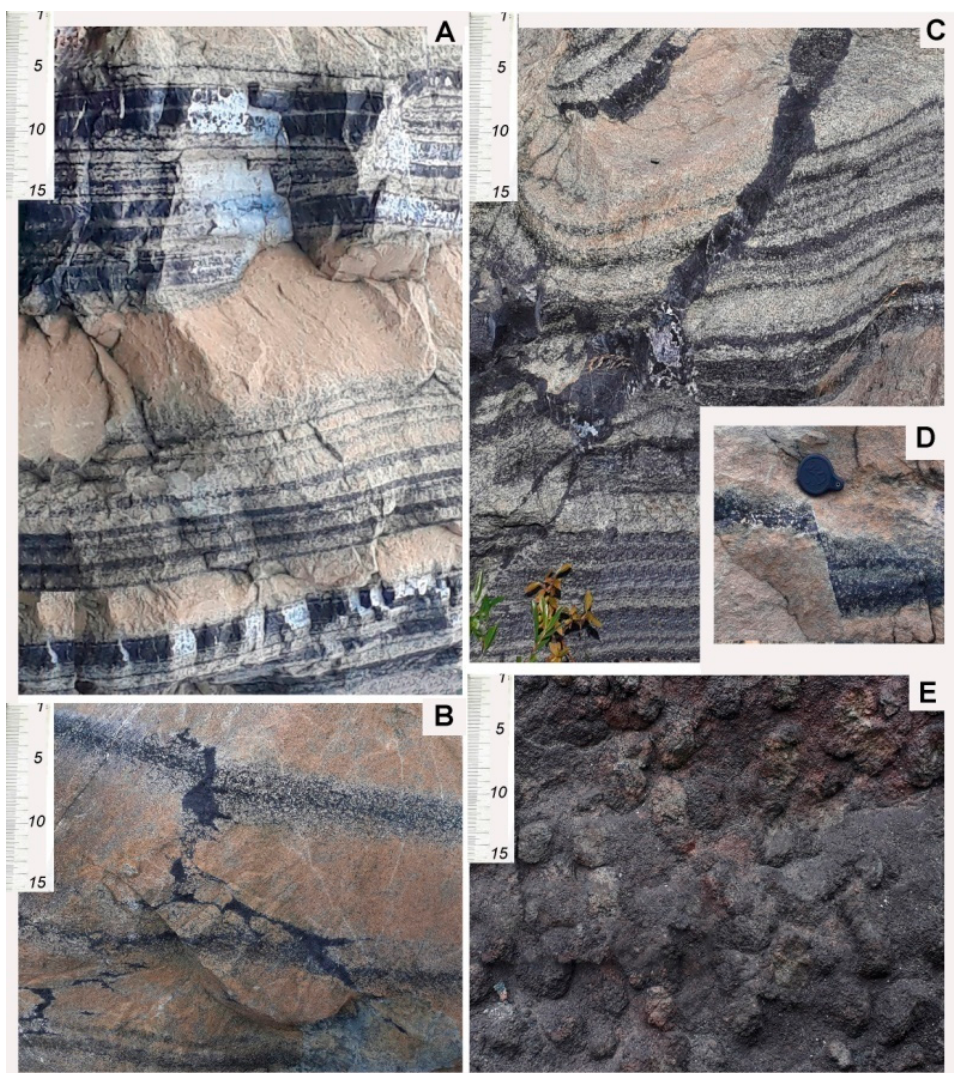
Figure 5. Features of the internal structure of the chromitite layers of the Sopcheozero deposit: ( A ) Alternation of rhythmically layered ore layers with host dunites; ( B ) Early segregations of ore matter in micro-fractures in ore layers with a cumulative structure; ( C ) Thin ore vein extending from the ore layer to the top along a diagonal crack in dunite; ( D ) Micro-displacement of the ore layer with massive and sideronite textures; ( E ) Nodular Cr-spinel of Mt. Kumuzhiya. Dimensions on the ruler are in cm.